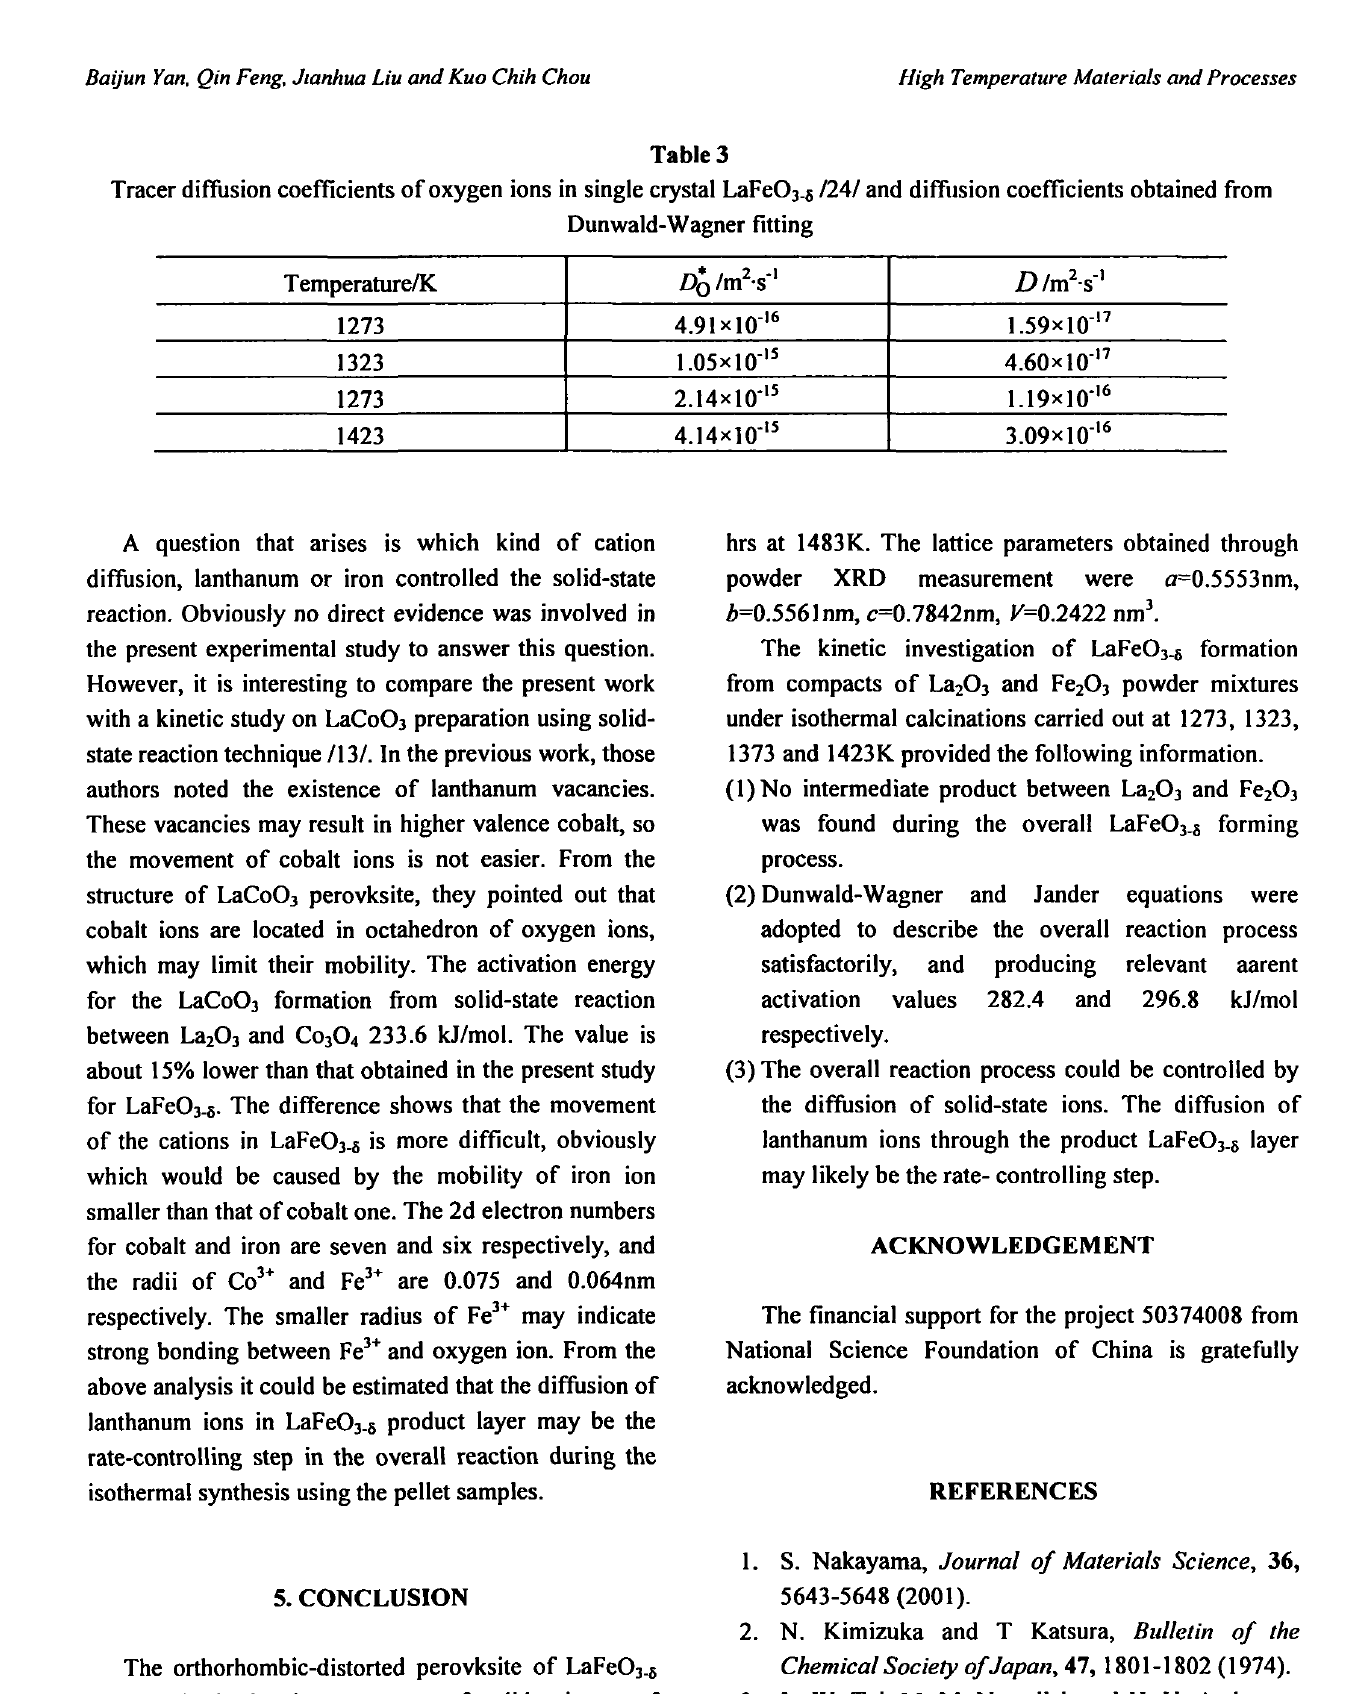
. /24/ and diffusion coefficients obtained 3 s